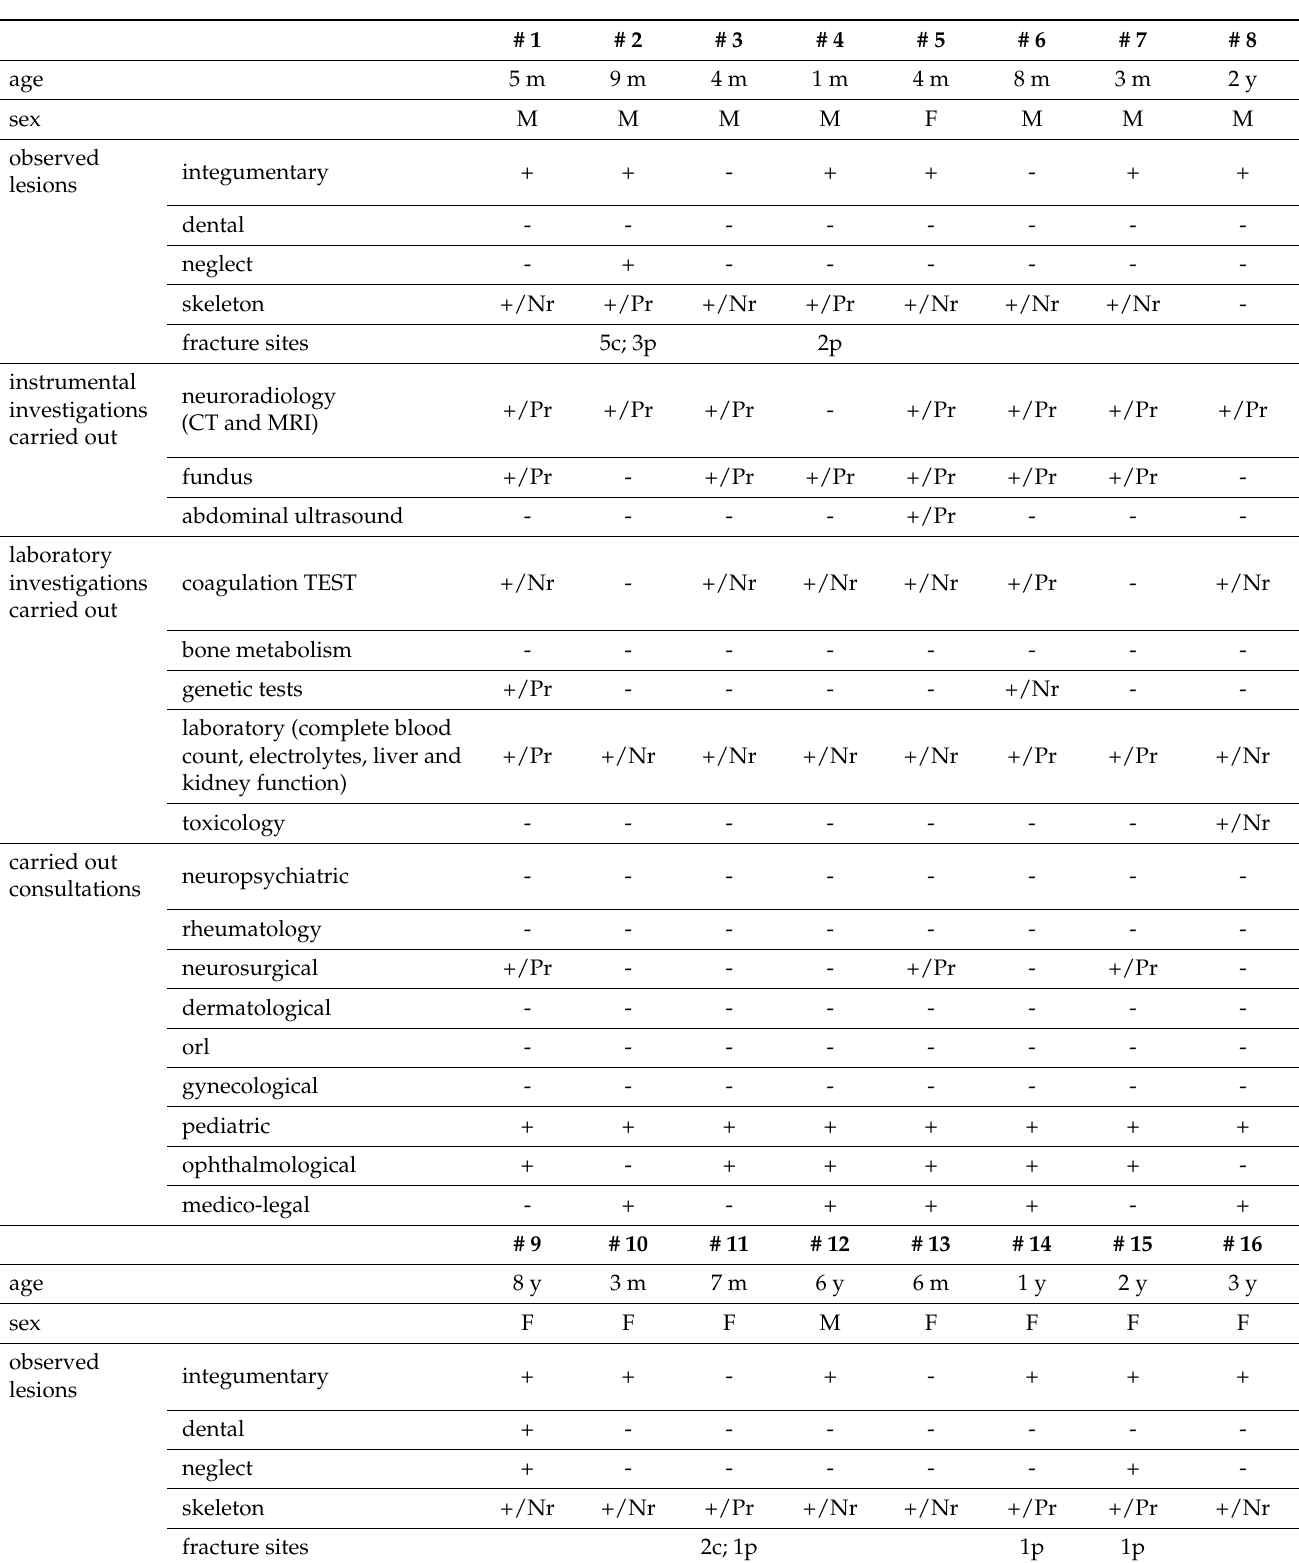
Table 1. Type of objective injury and the clinical, laboratory, and instrumental tests